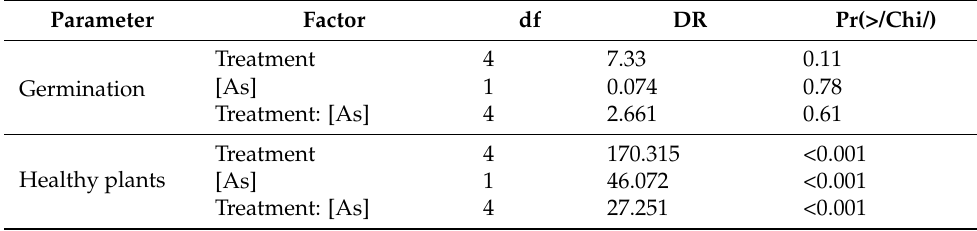
Figure 7. Gnotobiotic J.montana response to As (125 uM As(V)) under different treatments inoculated with helper bacteria, a non-helper bacterium or a mixture of bacteria. Natural control plants, gnotobiotic plants treated with streptomycin 24 h before planting and not inoculated, inoculated with Artlrobacter sp (non-helper bacteria), inoculated with a Pantoea conspicua (helper bacteria) and inoculated with a mixture of endophytic bacteria ( Pantoeaconspicua, Kocuriarosea, Kocuria sp.Rodococcus rhodochorus,Arthrobacter sp.). Table 3. GLM analyses to test the effect of arsenic (125uM As[V]) on germination and healthy devel- opment of J. montcma obtained by different treatments. Degrees of freedom (df), Deviance Residual (DR) and the probability associated to the estimation (Pr). Natural control plants (T1), gnotobiotic plants treated with streptomycin 24 hours before planting and no inoculated (T2), inoculated with Arthrobacter sp (non-helper bacteria; T3), inoculated with a Pantoea . conspicua (helper bacteria; T4) andinoculated with a mixture of bacteria (T5).